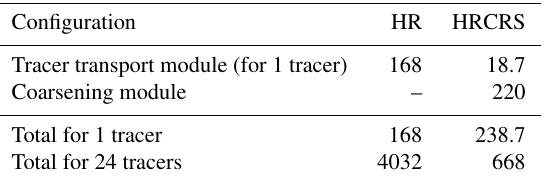
Table 4. Elapsed time (in seconds) for a 1-month run without/with the multi-grid algorithm. The values in the last row have been ex- trapolated.